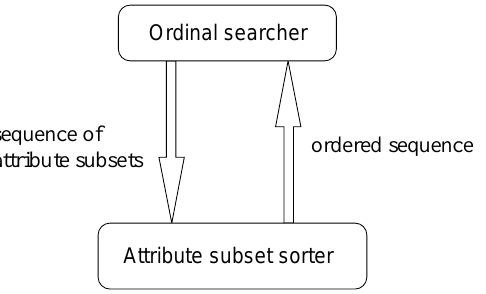
Figure 13. Schema of novel order-based feature selection. Ordinal searcher